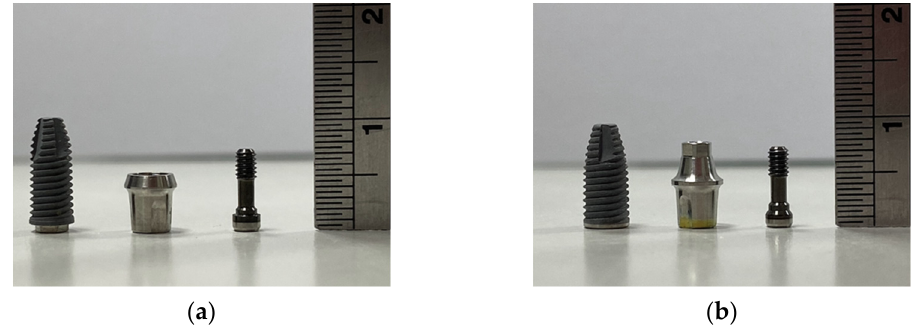
Figure 1. Components of the implant–abutment–screw systems: ( a ) S group: NobelSpeedy Groovy RP 4 mm × 10 mm with external hexagon; ( b ) C group: NobelParallel Conical Connection RP 4.3 mm × 10 mm with internal hexagon.